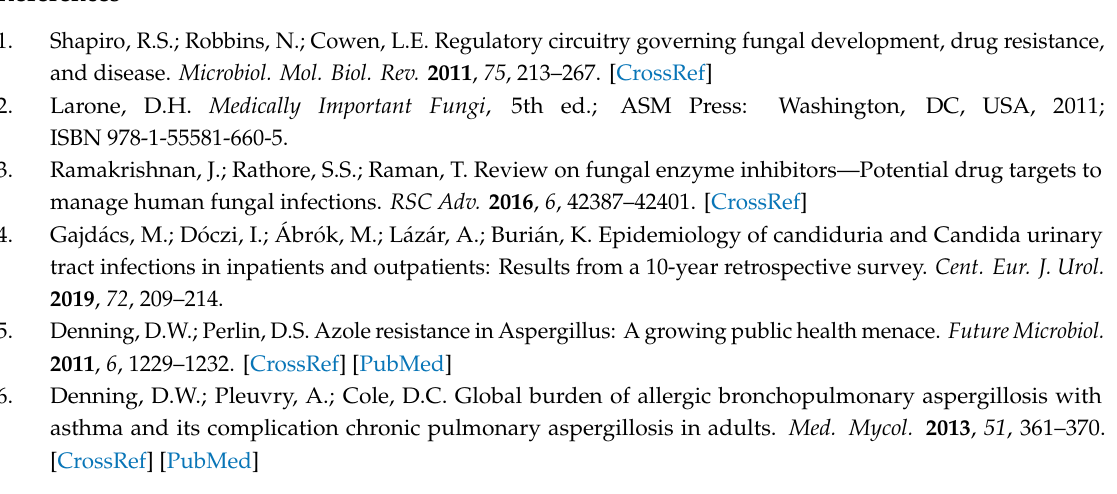
Supplementary Materials: The following are available online at http: // www.mdpi.com / 2076-2607 / 8 / 2 / 285 / s1. Table S1: The MIC values of ITR, POS and VOR after 20 and 25 transfers on Sabouraud agar Table S2: The MIC values of ITR, POS and VOR after 20 transfers on Sabouraud agar with addition of ITR, and then five transfers only on Sabouraud agar without any additions. Table S3: The MIC values of ITR, POS and VOR after 20 transfers on Sabouraud agar with addition of POS, and then five transfers only on Sabouraud agar without any additions. Table S4: The MIC values of ITR, POS and VOR after 20 transfers on Sabouraud agar with addition of VOR, and then five transfers only on Sabouraud agar without any additions. Table S5: The alteration of A. fumigatus mycelium after exposition of POS, ITR and VOR. Figure S1: The growth of A. fumigatus isolate on SAB medium without any additions. Figure S2: Colony morphology of isolate no. 2 cultured on A) SAB, B) SAB supplemented by 0.25 mg / L of VOR. Figure S3: Colony morphology of isolate no. 2 cultured on A) SAB, B) SAB supplemented by 1 mg / L of ITR. Figure S4: Colony morphology of isolate no. 2 cultured on A) SAB, B) SAB supplemented by 0.125 mg / L of POS. Figure S5: Colony morphology of isolate no. 2 cultured on A) SAB, B) SAB supplemented by 1 mg / L of ITR. Figure S7: Colony morphology of isolate no. 3 cultured on SAB supplemented by VOR, ITR, POS and only SAB after 3-5th passages. Figure S8: Colony morphology of isolate no. 55 cultured on SAB supplemented by VOR, ITR, POS and only SAB after 3–5th passages. Table S6: Raw data of cycle quantification values and standard deviation of tested